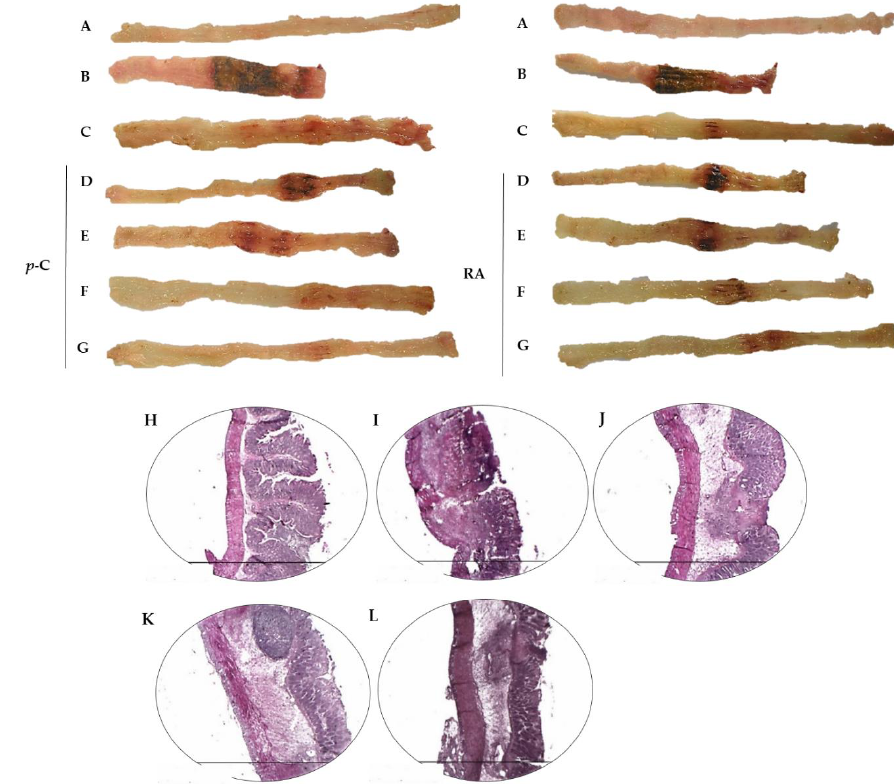
Figure 1. Representative images of rat colons from non-colitic group ( A ); colitic groups (5% Tween 80 or 0.9% NaCl treated groups) ( B ); prednisolone 2 mg/kg ( C ); p- C or RA (RA) 25 mg/kg ( D ), 50 mg/kg ( E ), 100 mg/kg ( F ), and 200 mg/kg ( G ) subjected to TNBS-induced ulcerative colitis model. The figure also shows representative hematoxylin–eosin (HE)-stained photomicrographs ( n = 3 per group) from ( H ) non-colitic; ( I ) colitic; ( J ) prednisolone 2 mg/kg; ( K ) p- C 200 mg/kg; and ( L ) RA 200 mg/kg. 40× magnification. Scale: 1500 µm.